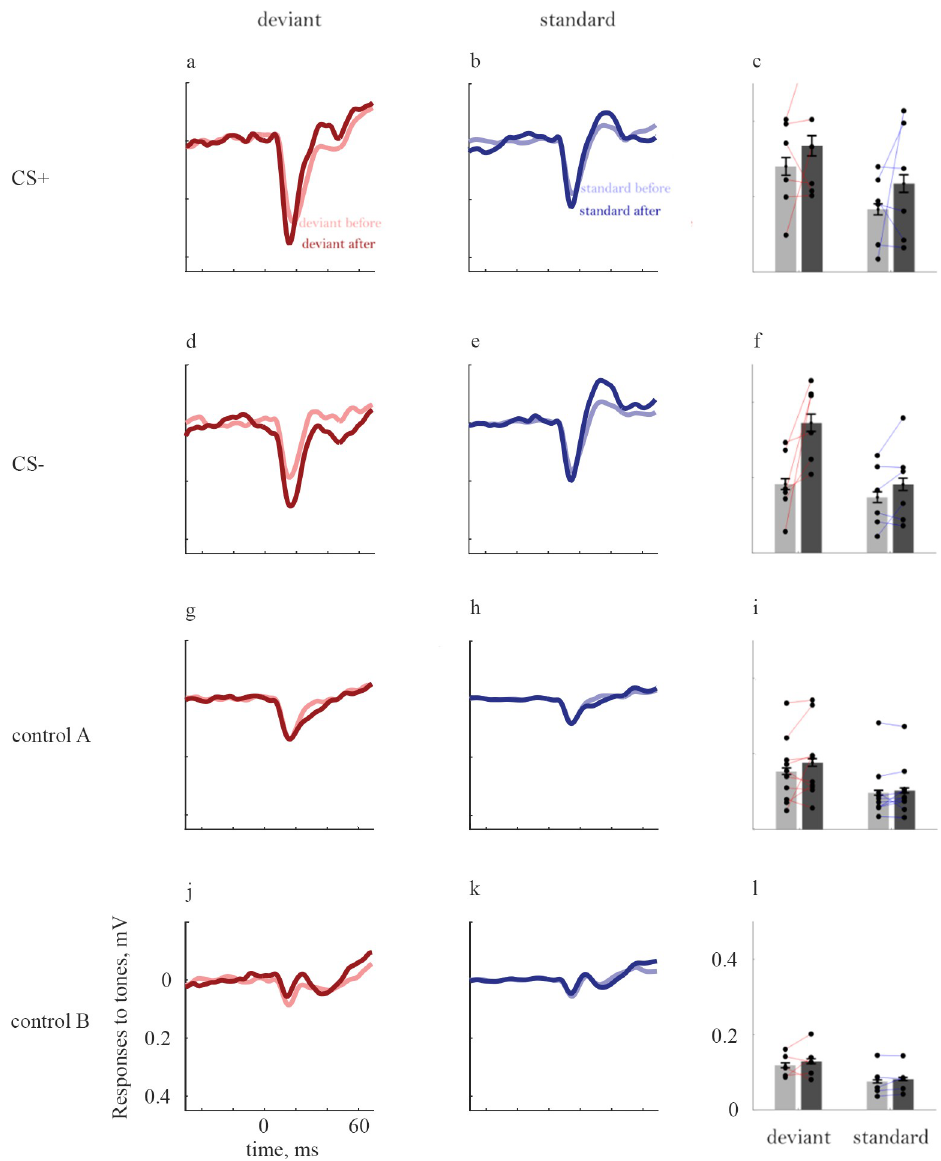
Fig 6. Changes in the responses to tones following conditioning. Same conventions and structure as Fig 5. Control A (g-i) in this case consists of the responses to tone stimuli in animals that have been conditioned to word-like